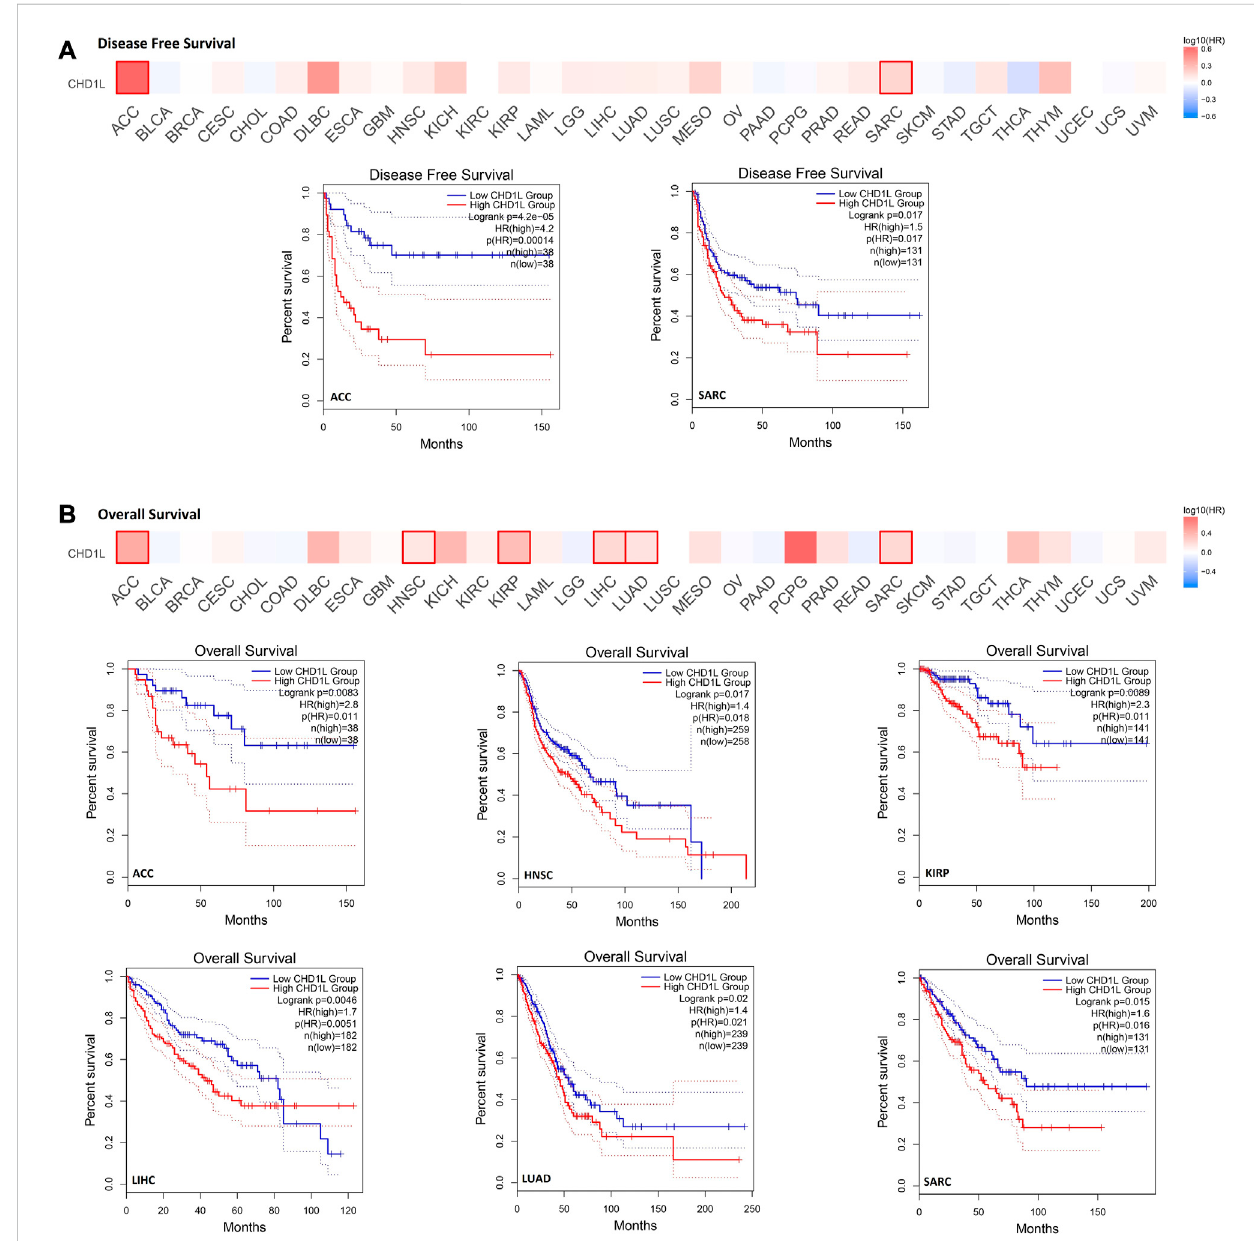
FIGURE 3 The correlation between CHD1L expression and the clinical outcome. (A) disease-free survival (B) overall survival as assessed from the GEPIA database.